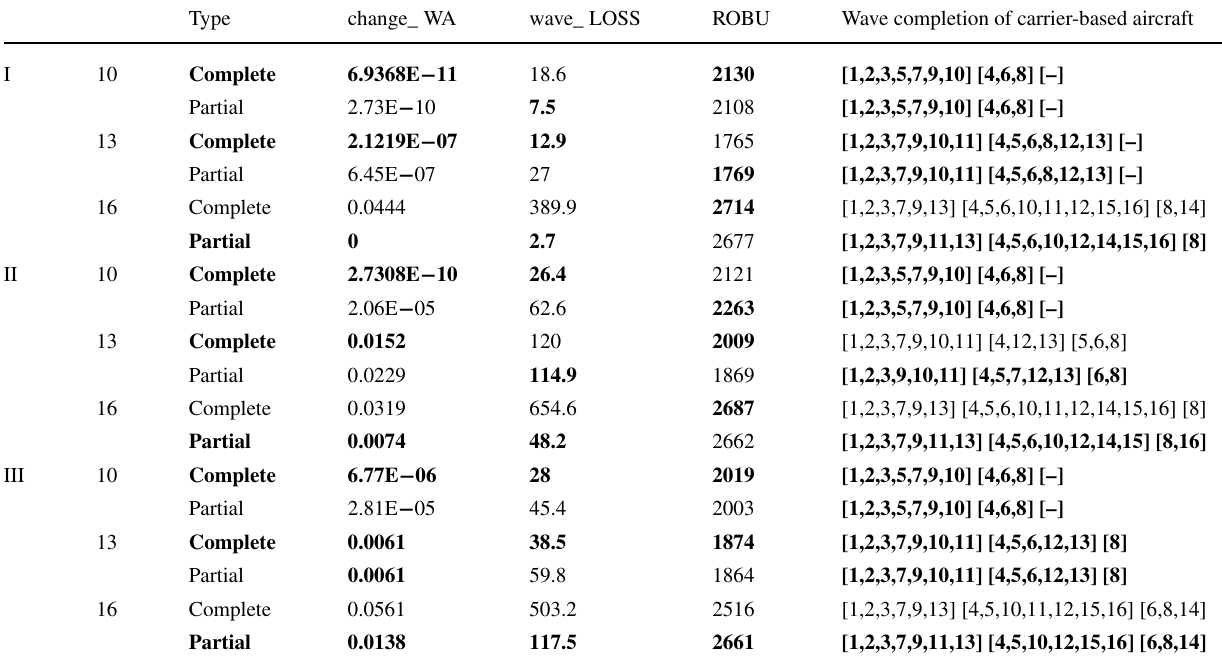
Table 5 Comparison results of two rescheduling